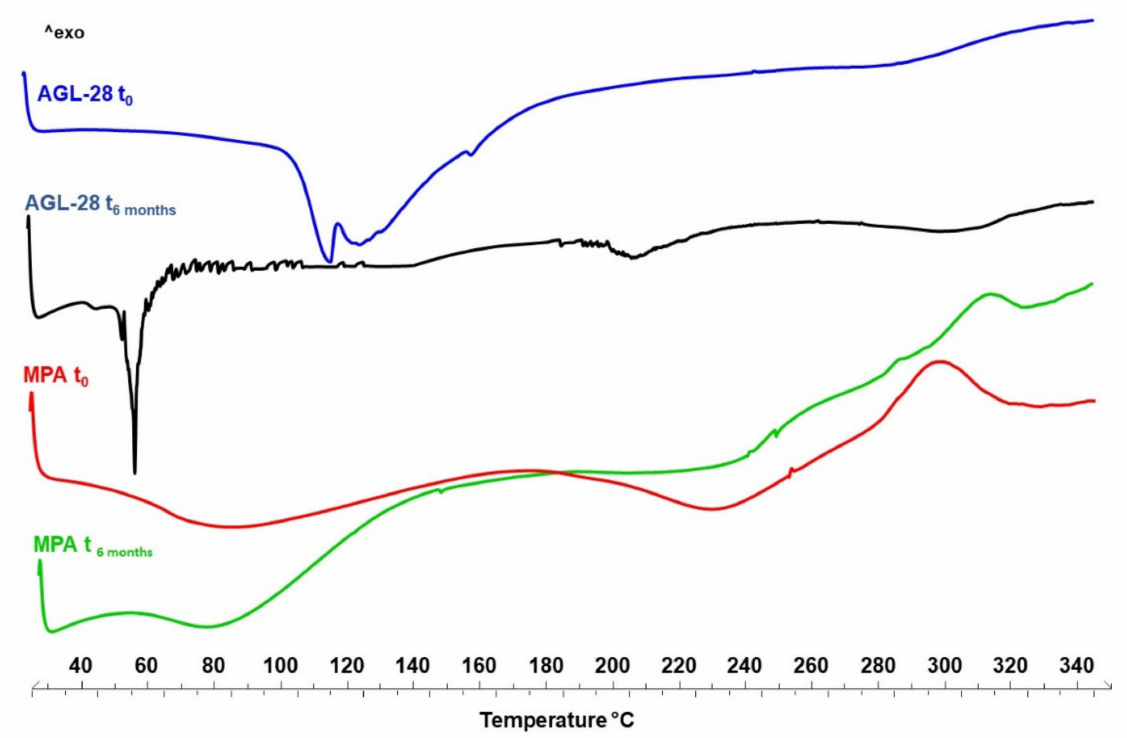
Figure 8. Thermal behavior by DSC analysis of AGL-28 extract (blue and black lines) and MPA powder (red and green lines) before and after 6 months of harsh storage